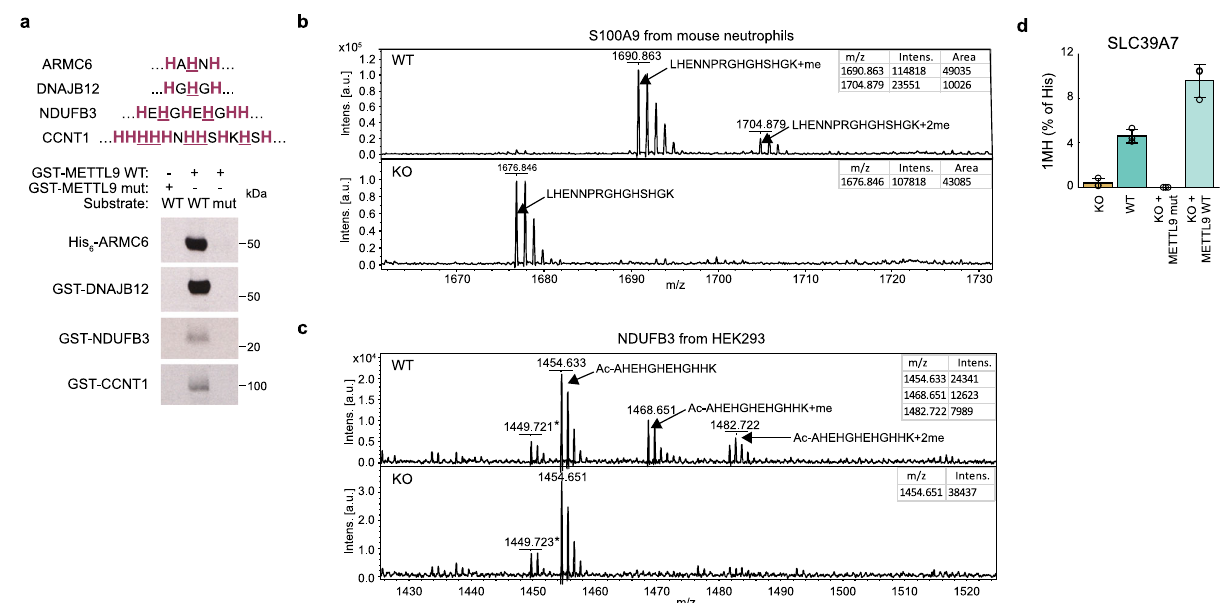
Fig. 4 Con fi rmation of METTL9-dependent protein histidine methylation in vitro and in vivo. a HxH-containing sequences of protein substrates with histidines marked in red and histidines mutated to arginines in the mutant substrates underlined (top). Fluorography showing in vitro activity of GST- hMETTL9 WT or E174A mutant (METTL9 mut) on the indicated proteins, either WT or with all HxH motifs removed by His-to-Arg mutations (mut) (bottom). 4 days exposure for ARMC6 and DNAJB12, 10 days exposure for CCNT1 and NDUFB3. b MALDI MS analysis of S100A9-derived peptides from WT and Mettl9 KO mouse neutrophils. c MALDI MS analysis of peptides from NDUFB3-FLAG immunoprecipitated from WT and METTL9 KO HEK293T cells. d Cellular SLC39A7 contains 1MH. The 1MH content of SLC39A7 immunoprecipitated from various HEK293-derived cells was determined by amino acid analysis. The following cells were used: WT, METTL9 KO (KO), KO complemented with WT C-terminally HA-tagged mMETTL9 (KO + METTL9 WT) or KO complemented with the corresponding D151K/G153R mutant (KO + METTL9 mut). Mean ± s.d ( n = 3 biologically independent samples). Source data are provided as a Source Data fi le. For the MALDI MS experiments ( b and c ), a table showing theoretical vs experimental mass of relevant peaks (and ppm deviation), as well as MASCOT results showing peptide coverage, can be found as Supplementary Data 1 and 2, respectively.